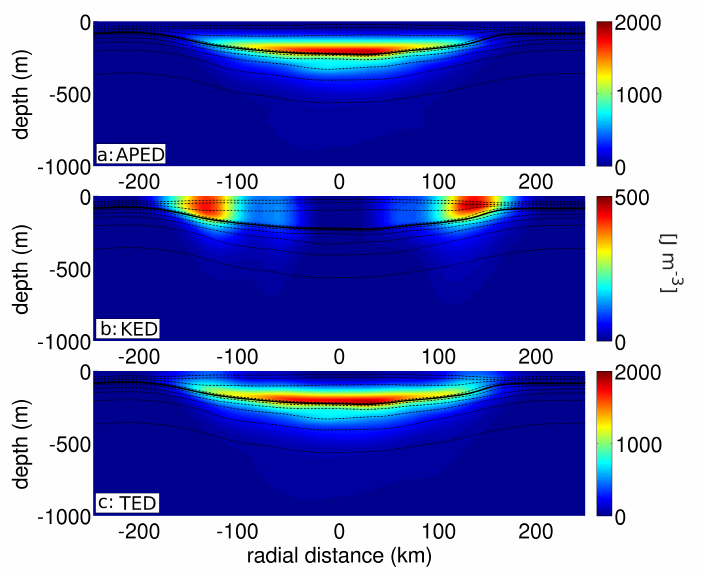
Figure 17. Vertical sections of energy density. ( a ) Available potential energy density. ( b ) Kinetic energy density. ( c ) Total energy